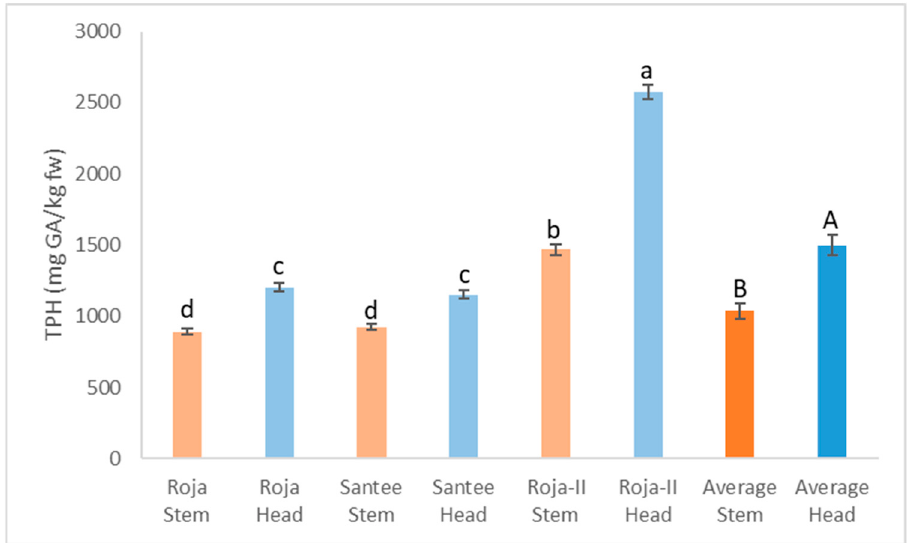
Figure 2. Average values of Total Phenol Content (TPH) with standard deviation of different cultivars and type of tissues of Broccoli: Roja, Santee and Roja-II harvest divided into head and stem, and their average. Values with the same lowercase letter were not significantly different (Test SNK p ≤ 0.05, n = 3). Lowercase letters refer to Roja, Santee and Roja II harvest divided into head and stem. Values with the same uppercase letter were not significantly different (Test SNK p ≤ 0.05, n = 9). Uppercase letters refer to head and stem average values.